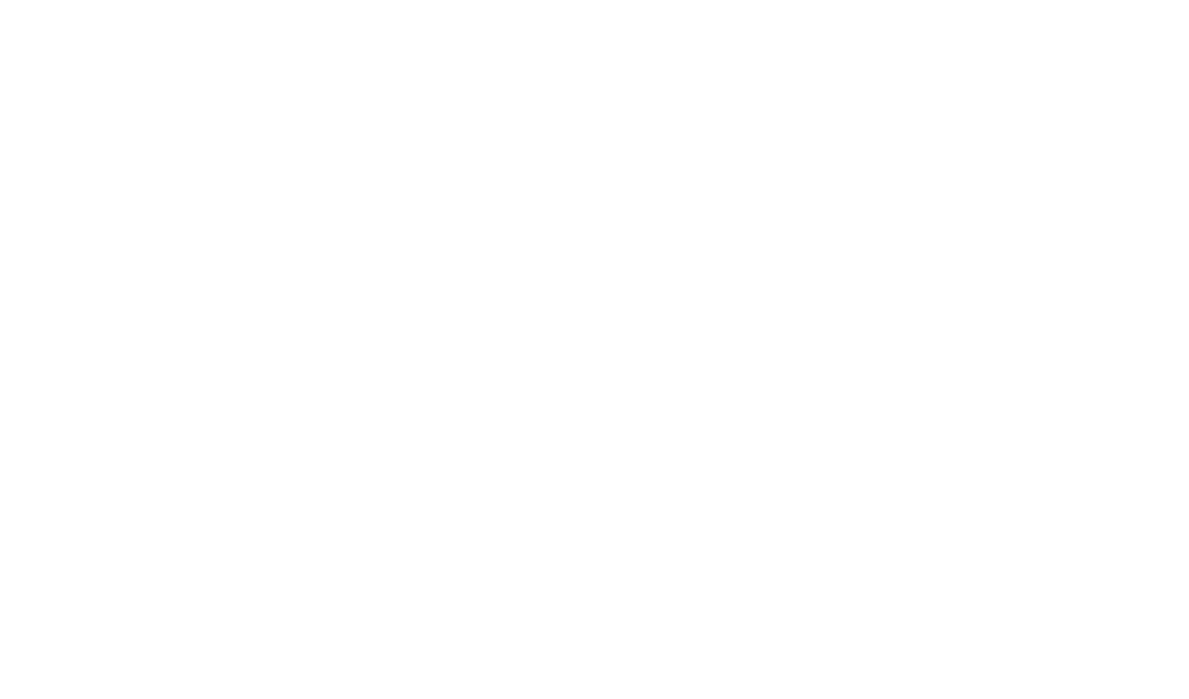
Fig. 64 Undercutting with varying etchant age on a Si{100}, b Si{110} ((i) acute corner and (ii) obtuse corner) in 20 wt% KOH 75 1 °C ±